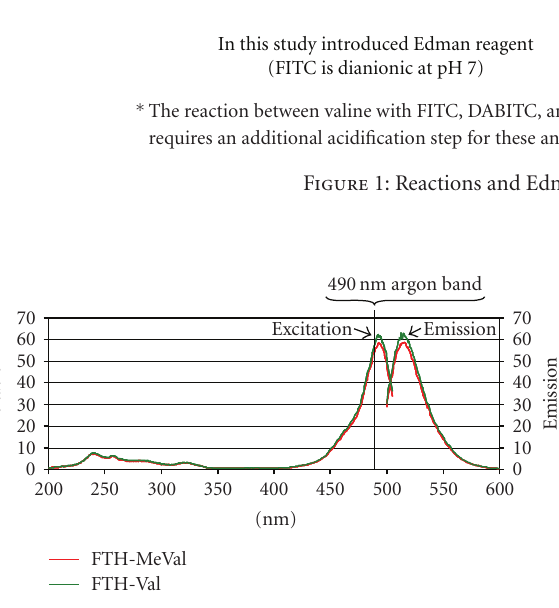
Figure 2: Fluorescence measurements; excitation and emission spectra of the dianions FTH-Val and FTH-MeVal recorded at pH